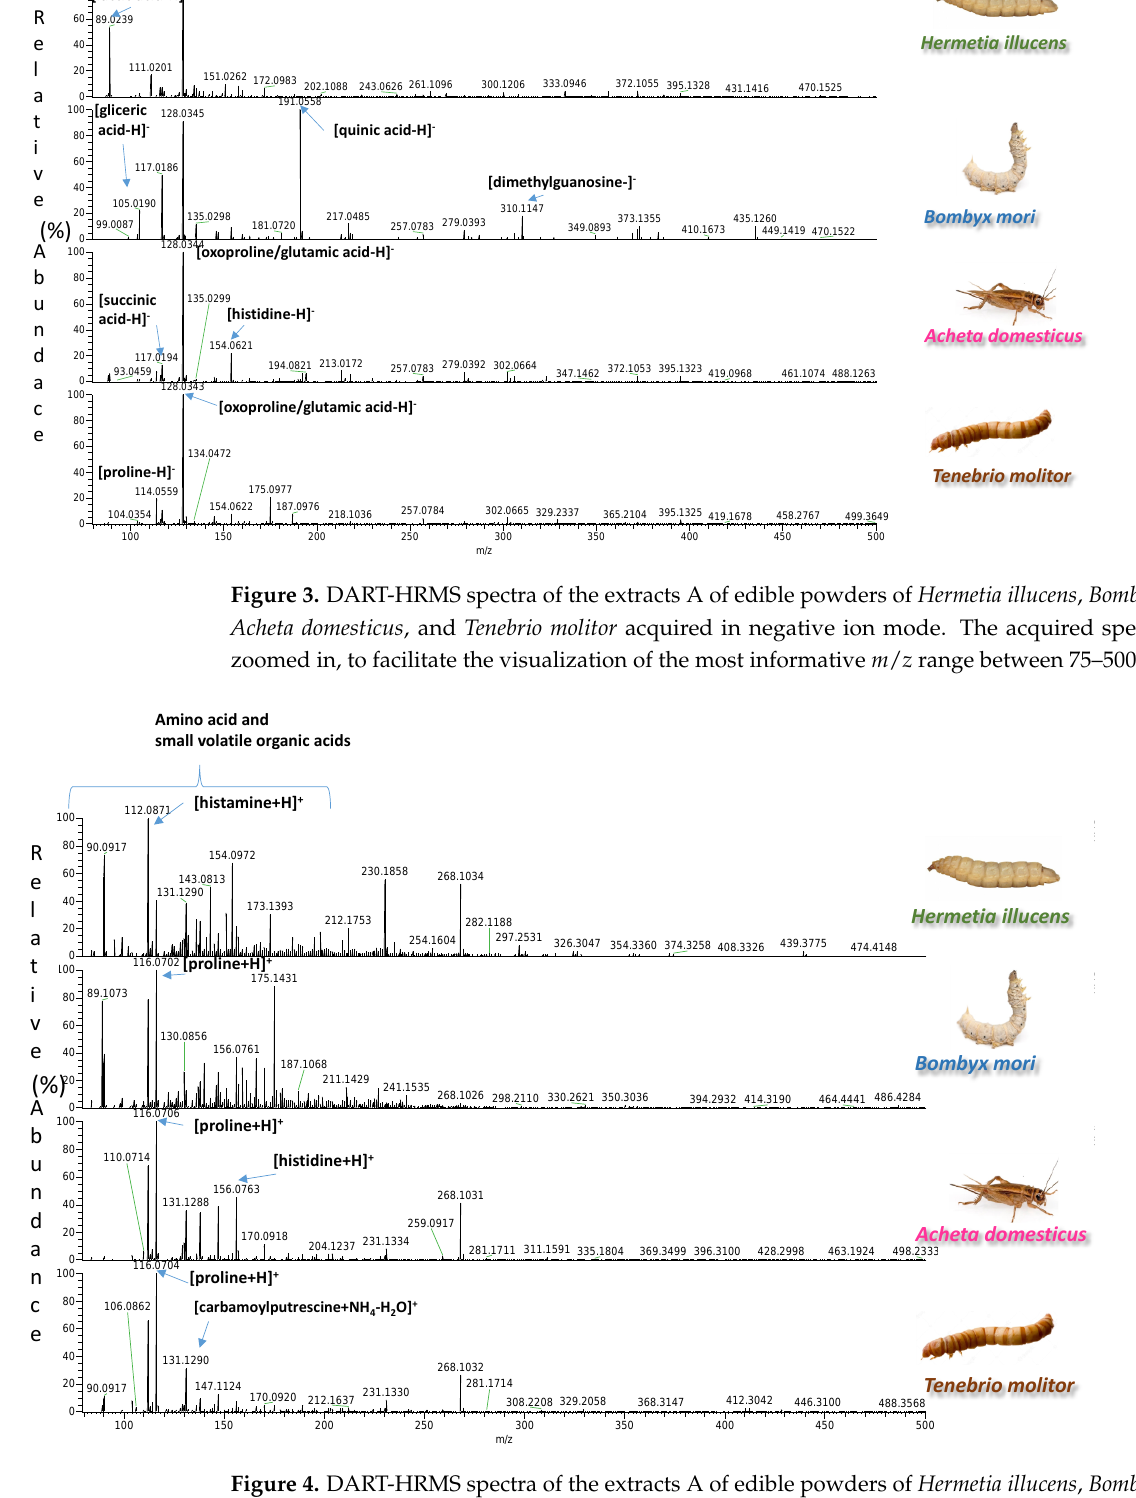
Figure 4. DART-HRMS spectra of the extracts A of edible powders of Hermetia illucens , Bombyx mori , Acheta domesticus , and Tenebrio molitor acquired in positive ion mode. The acquired spectra are zoomed in, to facilitate the visualization of the most informative m/z range between 75 – 500 Da.